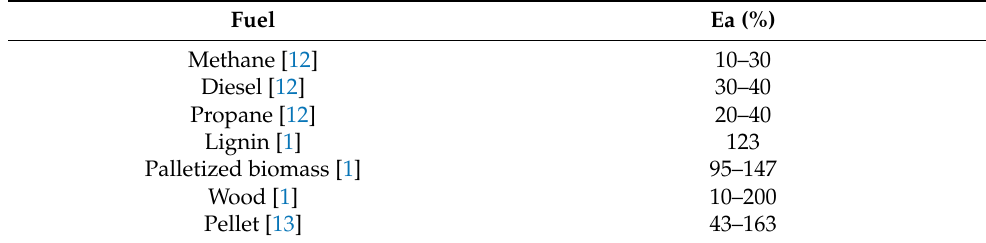
Table 4. Percentages of air excess for some